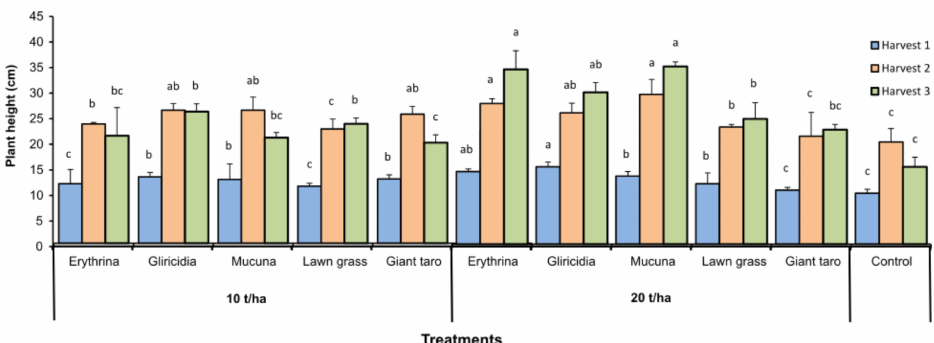
Figure 3. Interaction effect of organic amendments and their application rates (10 and 20 t ha − 1 ) on plant height (cm) of Chinese cabbage ( B. rapa cv. Chinensis) harvested at 14, 28 and 42 days after transplantation. Treatments having different lowercase letters are significantly different from each other at p <